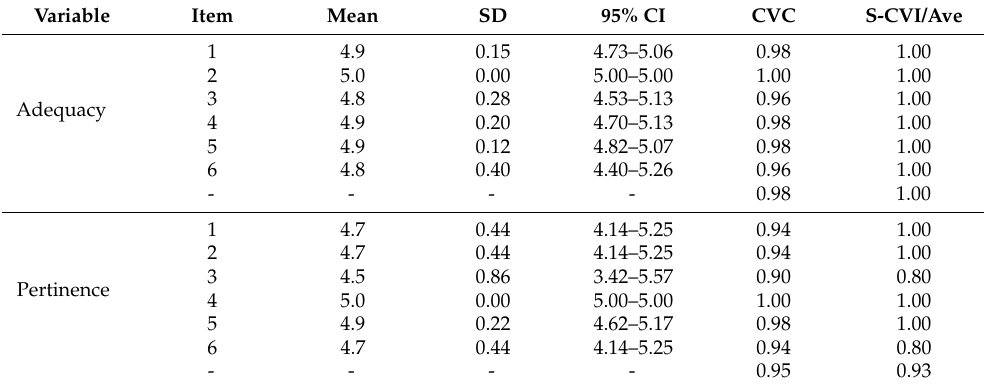
Table 1. Mean, standard deviation, confidence interval, and validity coefficient for adequacy and pertinence of the DF-FFQ instrument.